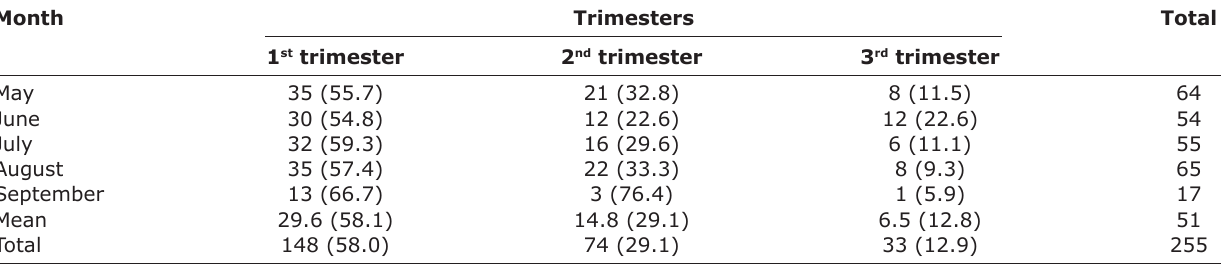
Values in bracket represent fetal wastage proportion (%) Table-3: Pregnancy status of the female cows slaughtered at the ELAKAT provincial